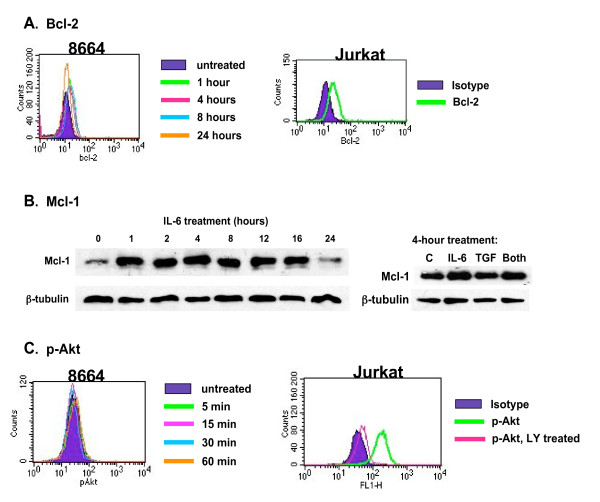
(A).Bcl-2 expression in LCL8664 cells treated with IL-6. LCL8664 cells were treated with IL-6 (20 ng/ml), or were untreated (untr), for time intervals between 1 – 24 hours. Bcl-2 expression was examined by intracellular flow cytometry. As a positive control, Bcl-2 expression in Jurkat cells was detected using the same methodology. (B). Immunoblot analysis of Mcl-1 expression in LCL8664 cells treated with IL-6 and/or TGF-β1. In the left panel, LCL8664 cells were treated with IL-6 (20 ng/ml) for time intervals between 0 – 24 hours. In the right panel, LCL8664 cells were treated with IL-6 (20 ng/ml), TGF-β1 (1 ng/ml), both, or were untreated (C) for 4 hours. The expression of β-tubulin was examined as a loading control. (C). Activated (phosphorylated) Akt expression in LCL8664 cells treated with IL-6. LCL8664 cells were treated with IL-6 (20 ng/ml), or were untreated (untr), for time intervals between 0 – 60 minutes. Phosphorylated Akt (p-Akt) expression was examined by intracellular flow cytometry. As a positive control, p-Akt expression in Jurkat cells was detected using the same methodology, in the presence or absence of LY294002 (50 βM).